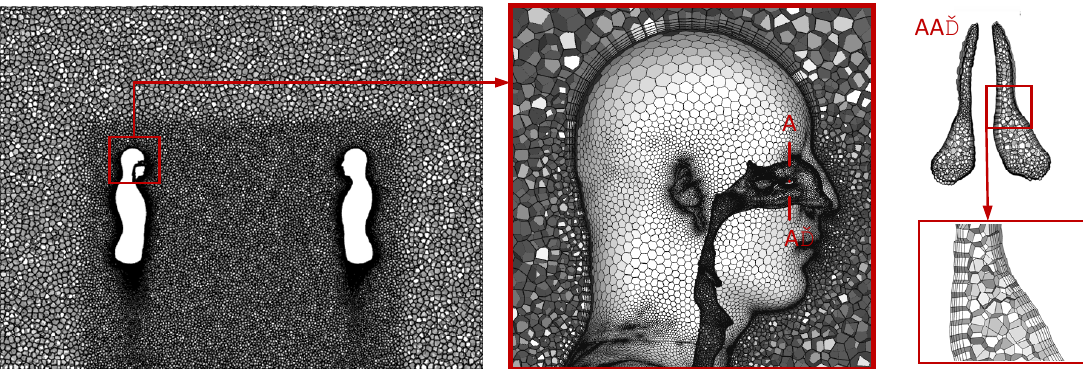
Figure 2. The hybrid mesh details.